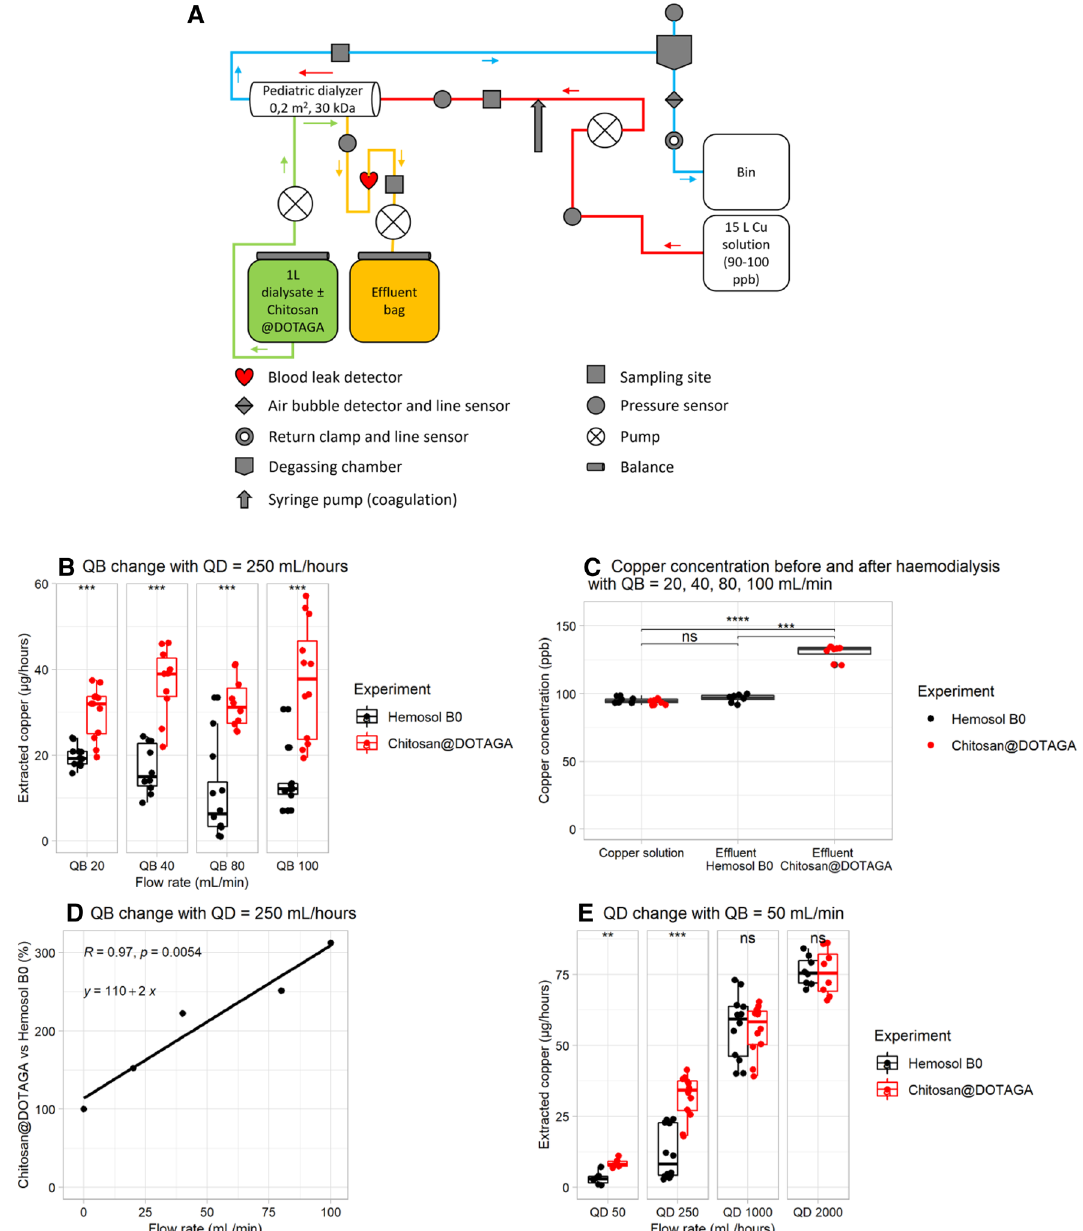
Figure 3. In vitro experiment designated for showing copper extraction due to dialysis with Chitosan@ DOTAGA. ( A ) Schematic representation of the experiment. ( B ) Amount of copper extracted (µg/h) from the copper II solution with (red) or without (black) Chitosan@DOTAGA according to increased blood flow rates (QB) (mL/min). ( C ) Copper concentration in the copper solution before dialysis and in the effluent (ppb) with (red) or without (black) Chitosan@DOTAGA with QB = 20, 40, 80 and 100 mL/min and QD (dialysate flow rate) = 250 mL/h. ( D ) Percentage ratio of copper extraction capacity between Chitosan@DOTAGA and the Hemosol B0 alone according to QB (mL/min). The linear regression slope equation ‘y = b + ax’ is presented along with the correlation coefficient (R) and the Pearson correlation p value (p). ( E ) Amount of copper extracted (µg/h) from the copper solution with (red) or without (black) Chitosan@DOTAGA according to QD (mL/h). Stars indicates significant differences according to non-parametric Kruskal–Wallis tests (NS: non-significant, *: p value < 0.05, **: p value < 0.01, ***: p value <